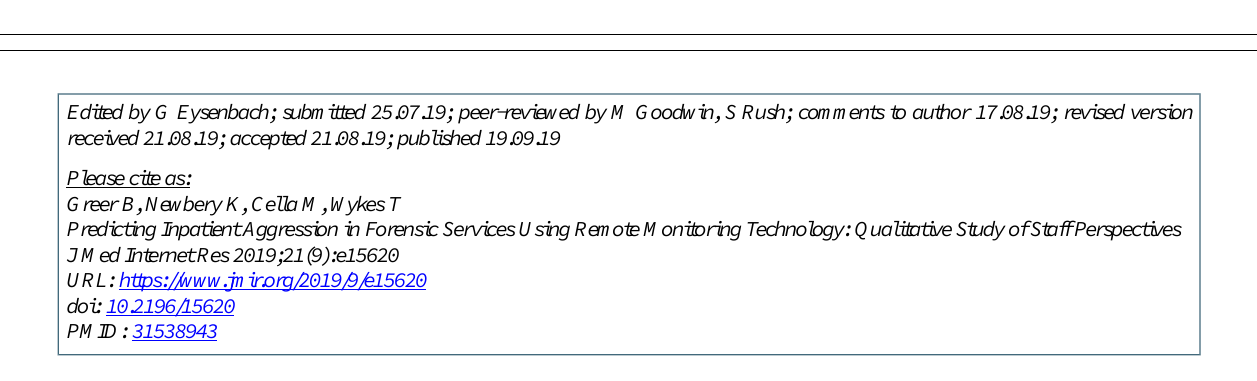
Abbreviations GPS: global positioning